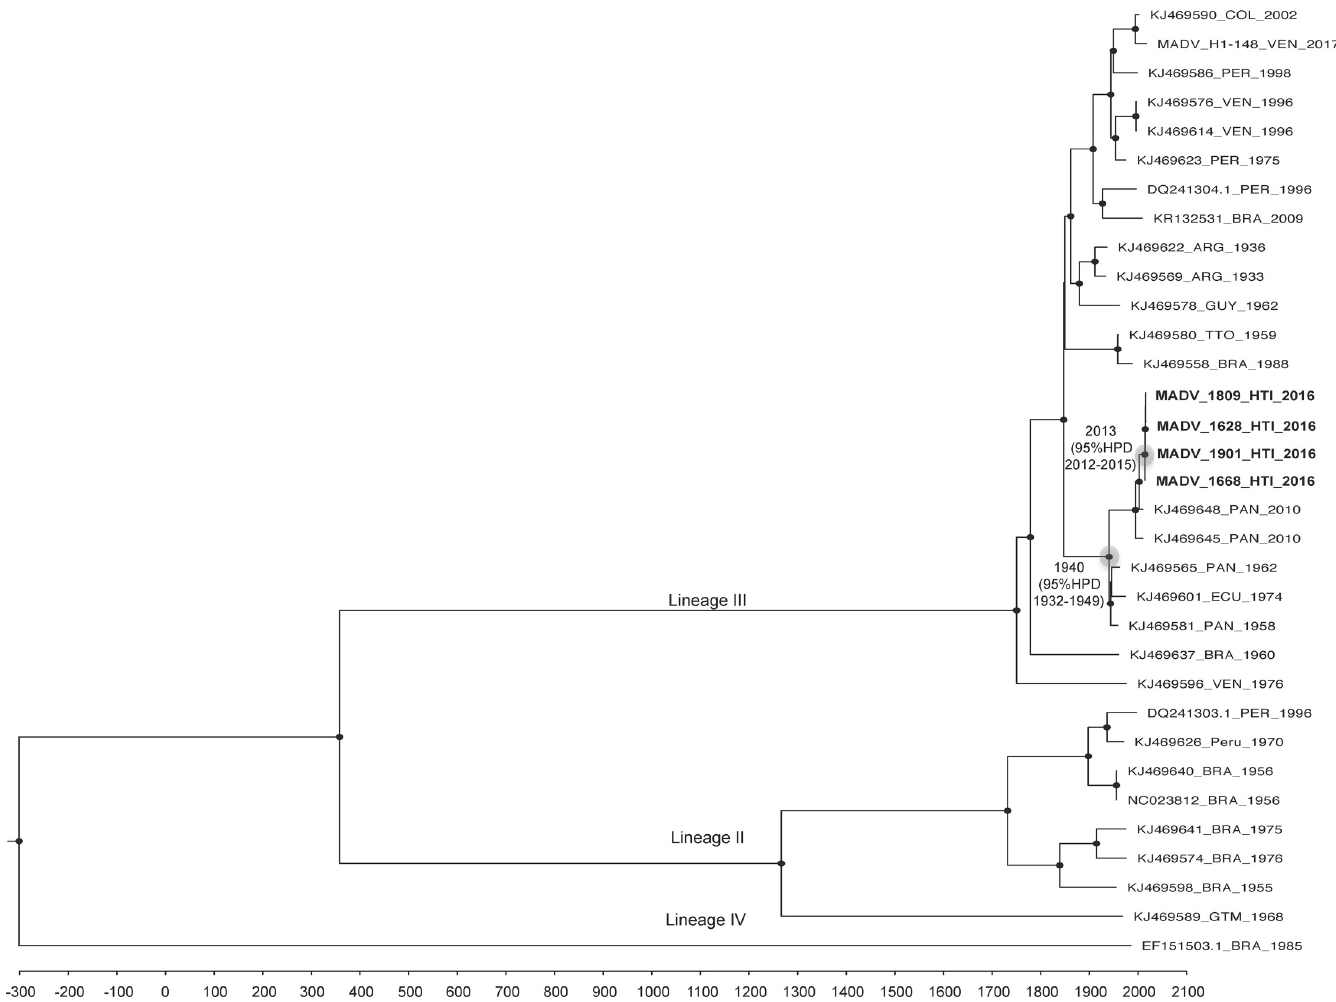
Fig 3. Bayesian phylogenetic tree based on the full genome of MADV isolates. The time-scaled MCC phylogeny was inferred based on a strict clock and a constant demographic prior model. MRCA for the Central American monophyletic sub lineage and the Haitian cluster are indicated with a light gray circle and tMRCA is reported at node. Robustness for internal branches defined as posterior probability PP > 0.9 is indicated by black circles at nodes.